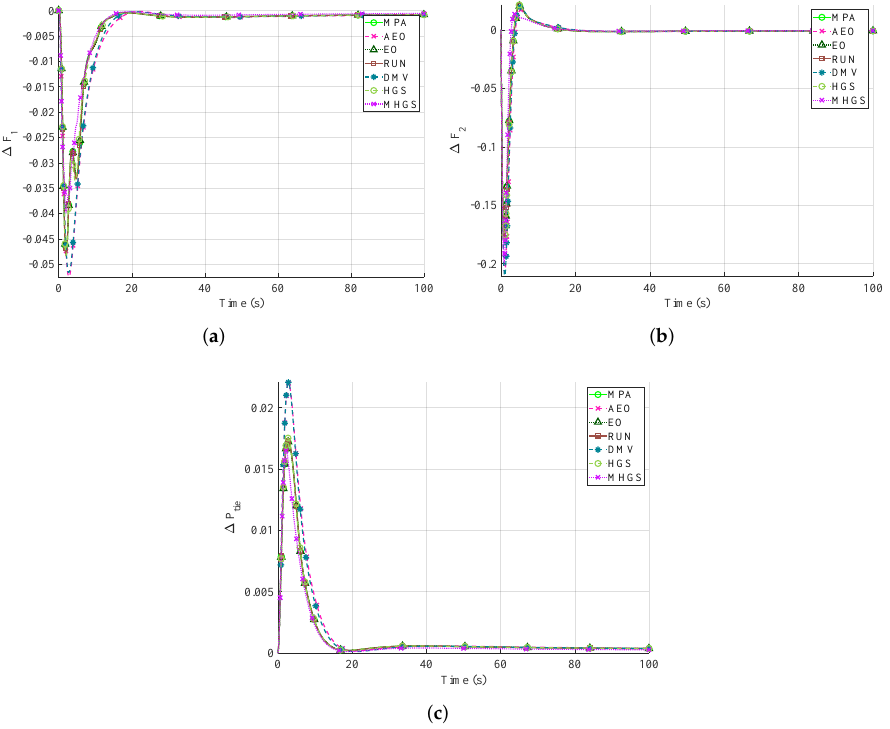
Figure 11. Time responses of ( a ) ∆ F 1 , ( b ) ∆ F 2 , and ( c ) ∆ P tie at 10 % load disturbance applied on area 2. Robustness Evaluation under Variable Disturbance: Two